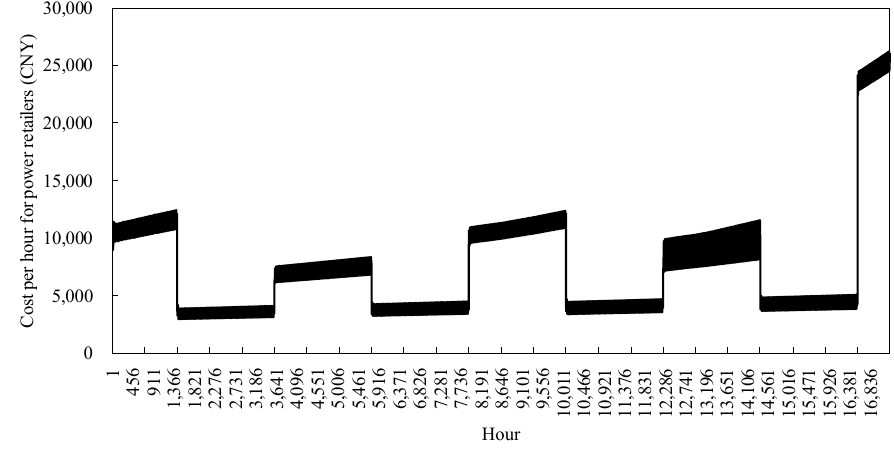
Figure 12. Cost of power retailers.